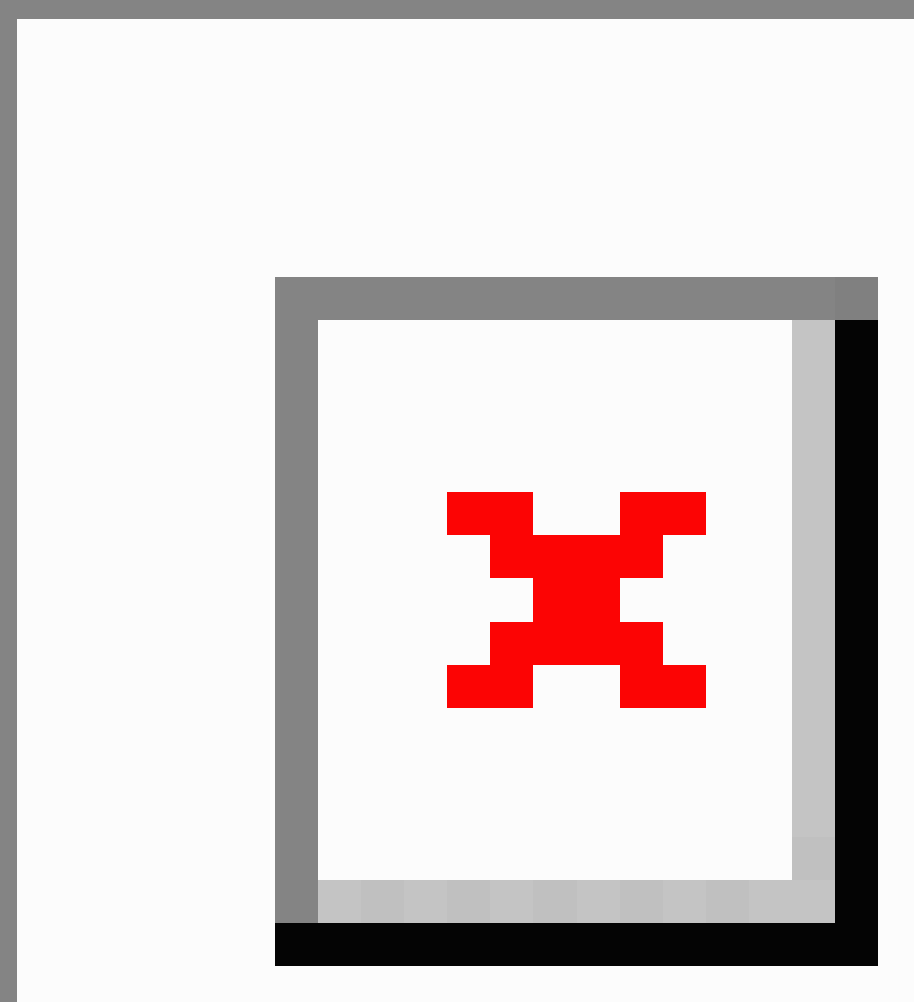
Figure 6. Number of ePrescription messages sent per prescribing